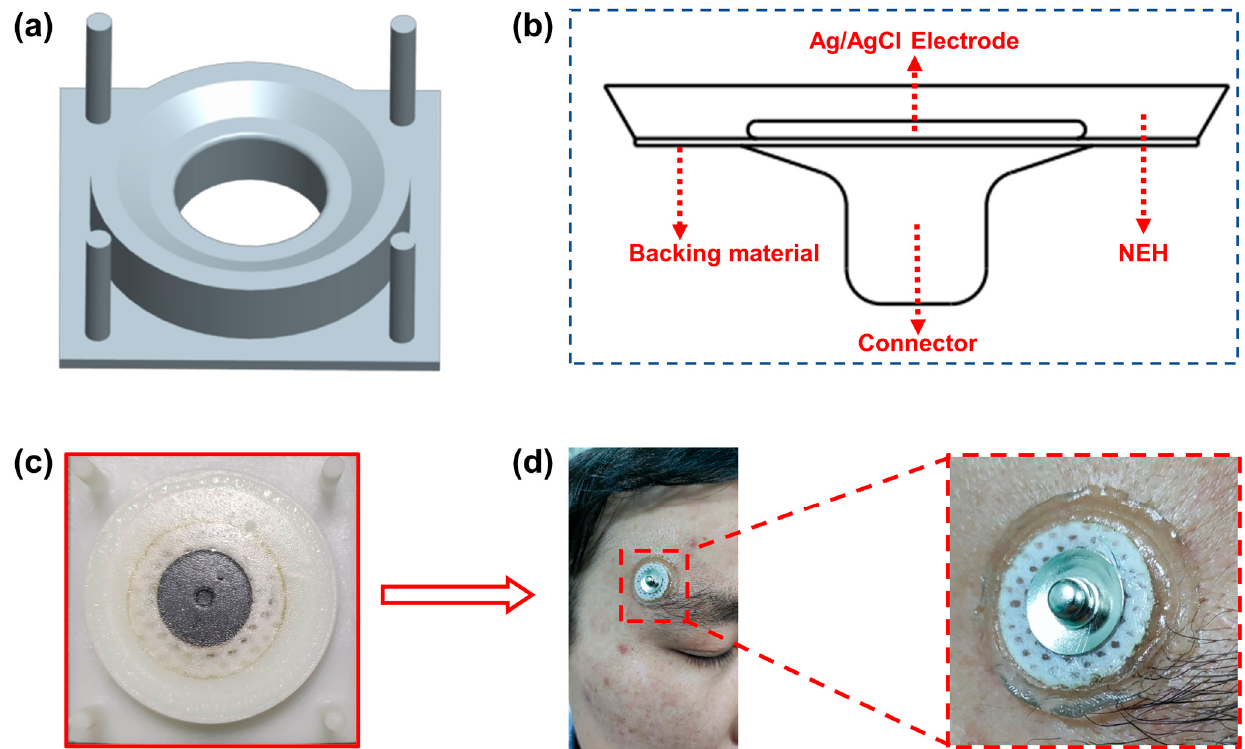
Figure 6. ( a ) Schematic illustration for self-adhesive electrode mold. ( b ) Schematic illustration of the structure of the NEH self-adhesive electrode. ( c ) Image of the NEH self-adhesive electrode manufacturing process. ( d ) Image of NEH self-adhesive electrode adhering to the skin of forehead. Compared with ECG and EMG, EEG signals are so weak (at µV level) that it is easy